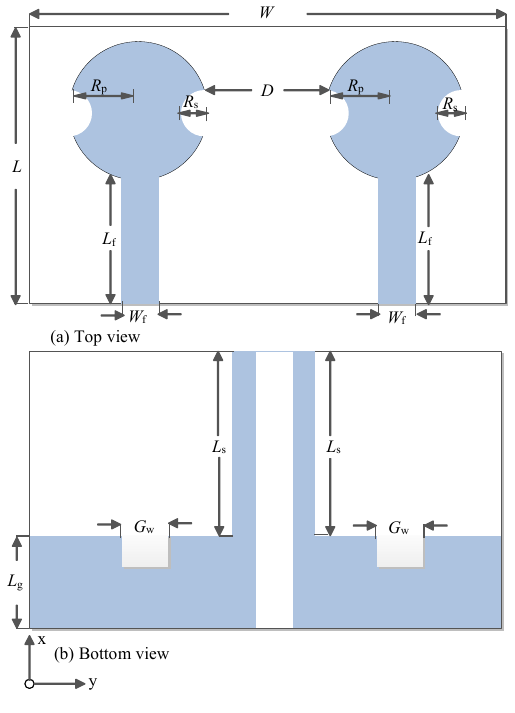
Fig. 1. System model: (a) top view, (b) bottom view.